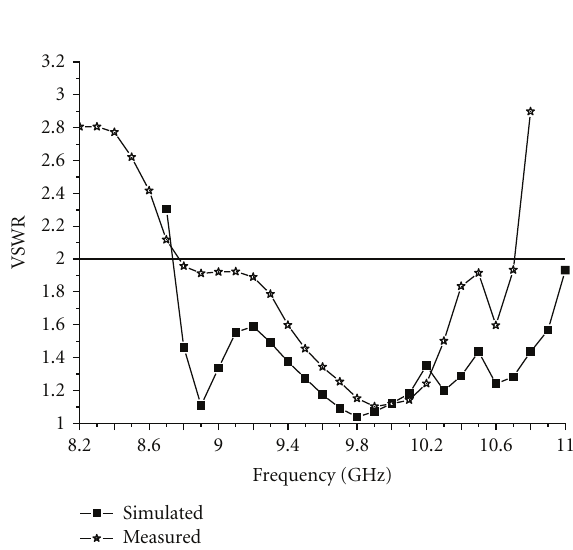
Figure 1: Geometry of dielectric rod antenna.